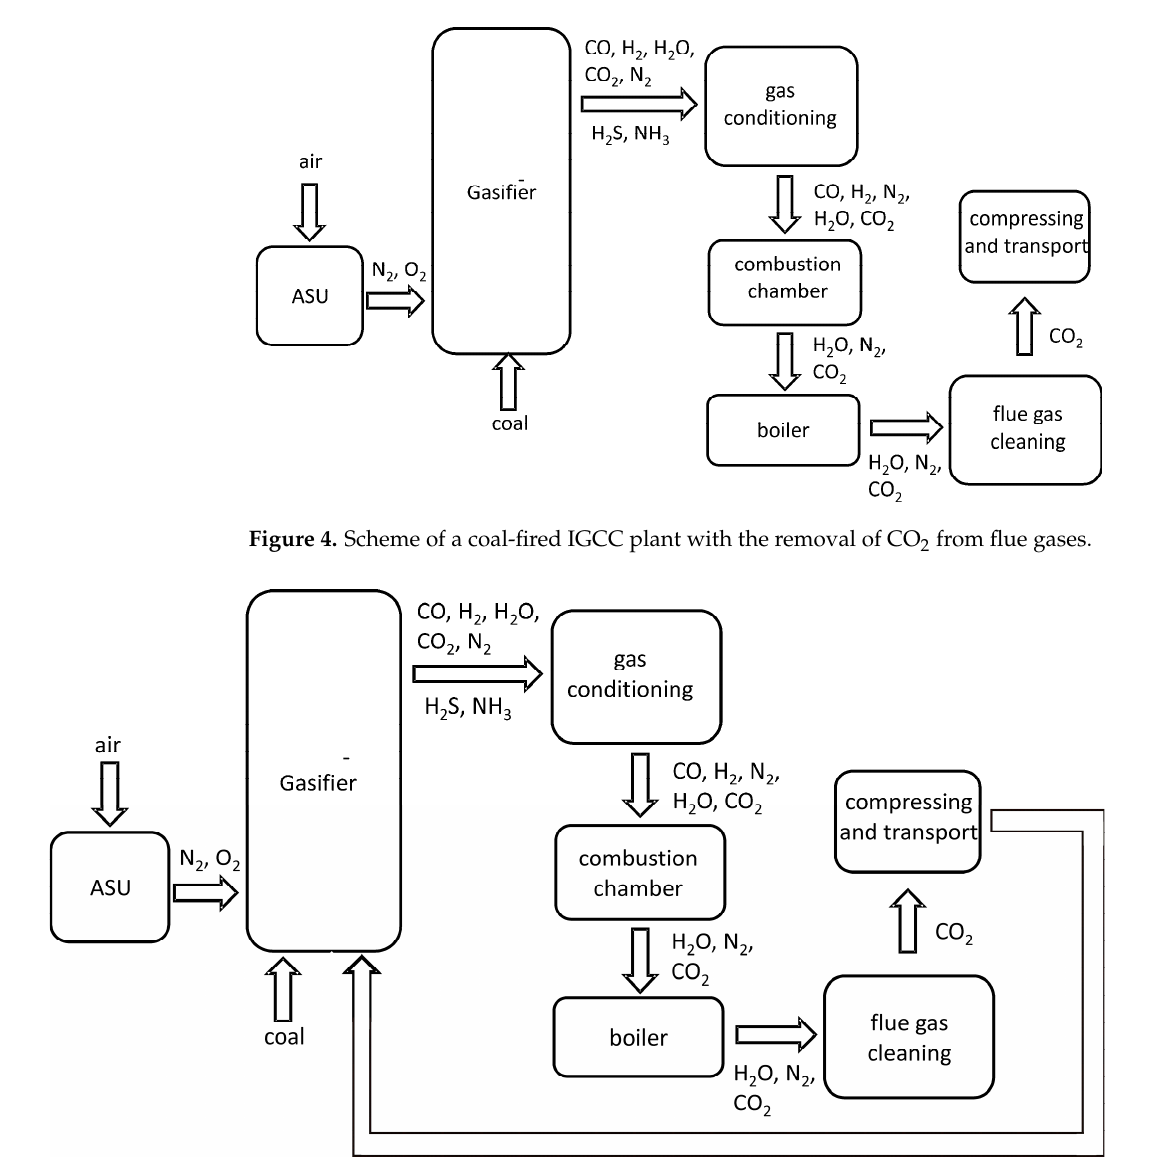
Figure 3. The basic scheme of a coal-fired IGCC plant.